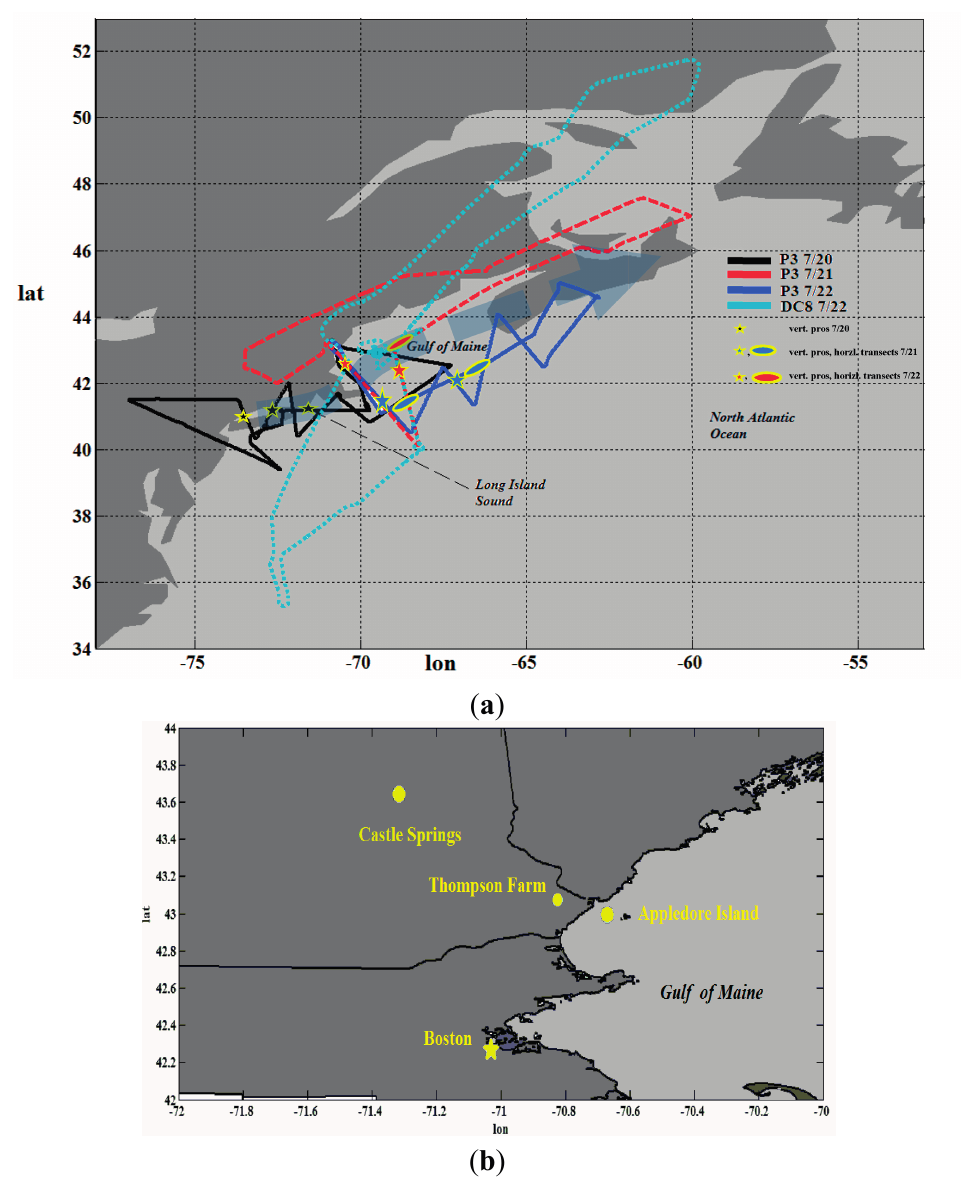
Figure 1. The region of interest with flight tracks of the NOAA P3 and NASA DC-8 on 7/20, 7/21, and 7/22 is shown in ( a ); A highlighted sub-region encompassing the three AIRMAP surface stations used is presented in ( b ). A grey arrow marks the path of the plume as described in previous